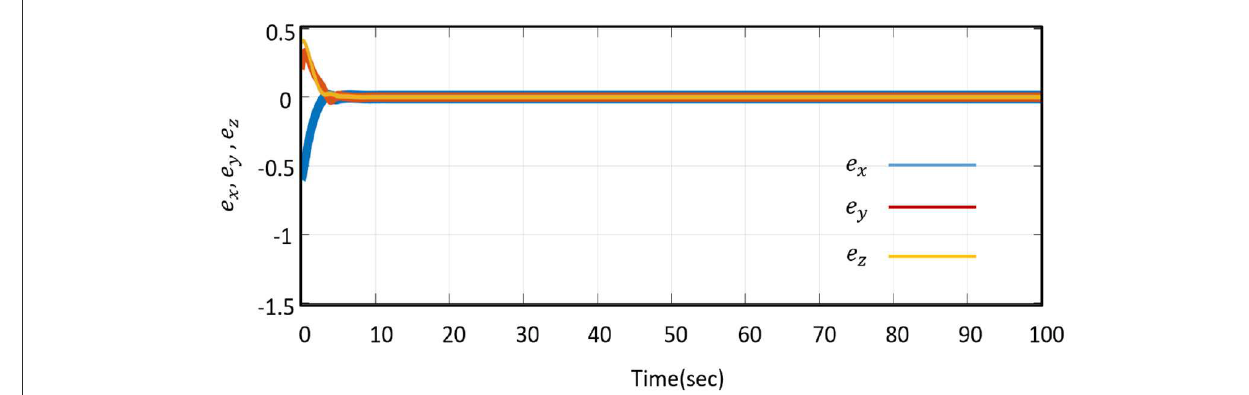
FIGURE9 Tracking error e x , e y , e z .